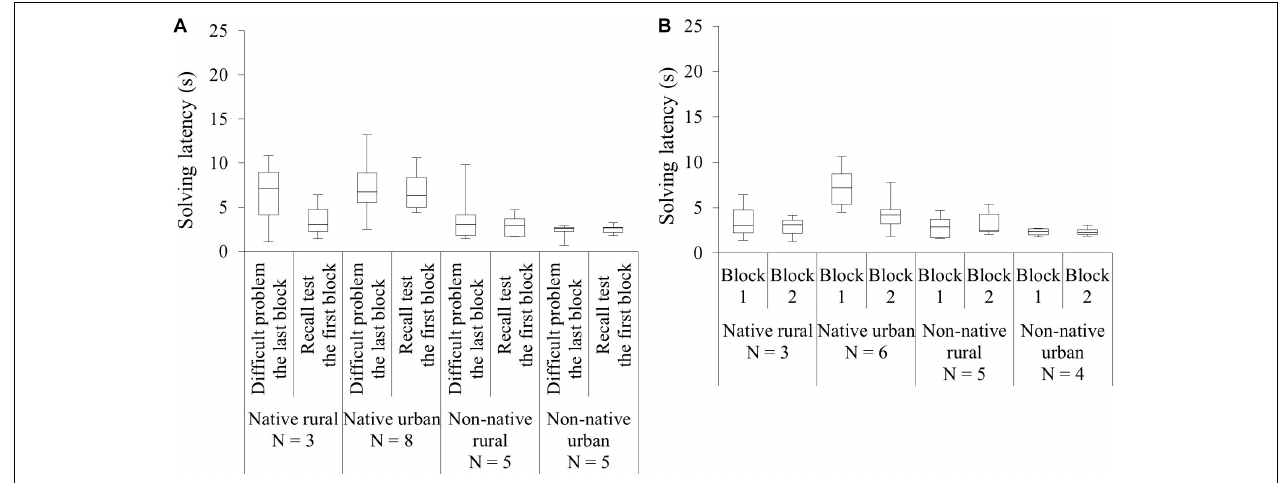
FIGURE 4 | Comparison of the performance in the recall test among the four squirrel groups (native rural, native urban, non-native rural, and non-native urban group). (A) The very last block (i.e., mean total latency of the last five successes) of the difficult problem and the first block (i.e., mean total latency of the first five successes) of the recall test for each group. (B) The first block and the second block of the recall test across 2 blocks of 5 successes (10 successes) for each group. TABLE 4 | The recall test: GLMM and Bayesian approach testing the effect of squirrel group (native rural, native urban, non-native rural, and non-native urban group) on success block number, and their interaction on recall latency. Task